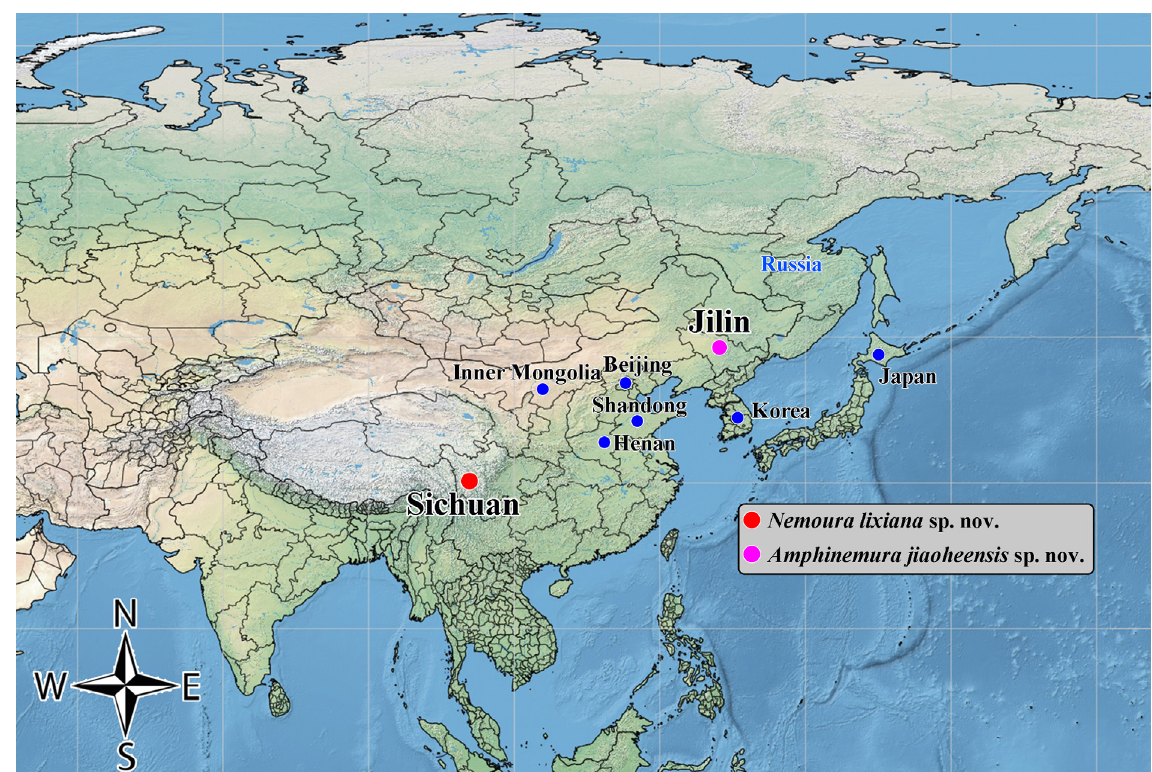
Fig. 1. Collecting localities of Nemoura lixiana sp. nov. (red spot) and Amphinemura jiaoheensis sp. nov. (pink spot) in China. General distribution of Nemoura geei Wu, 1929 is marked with blue spots or blue